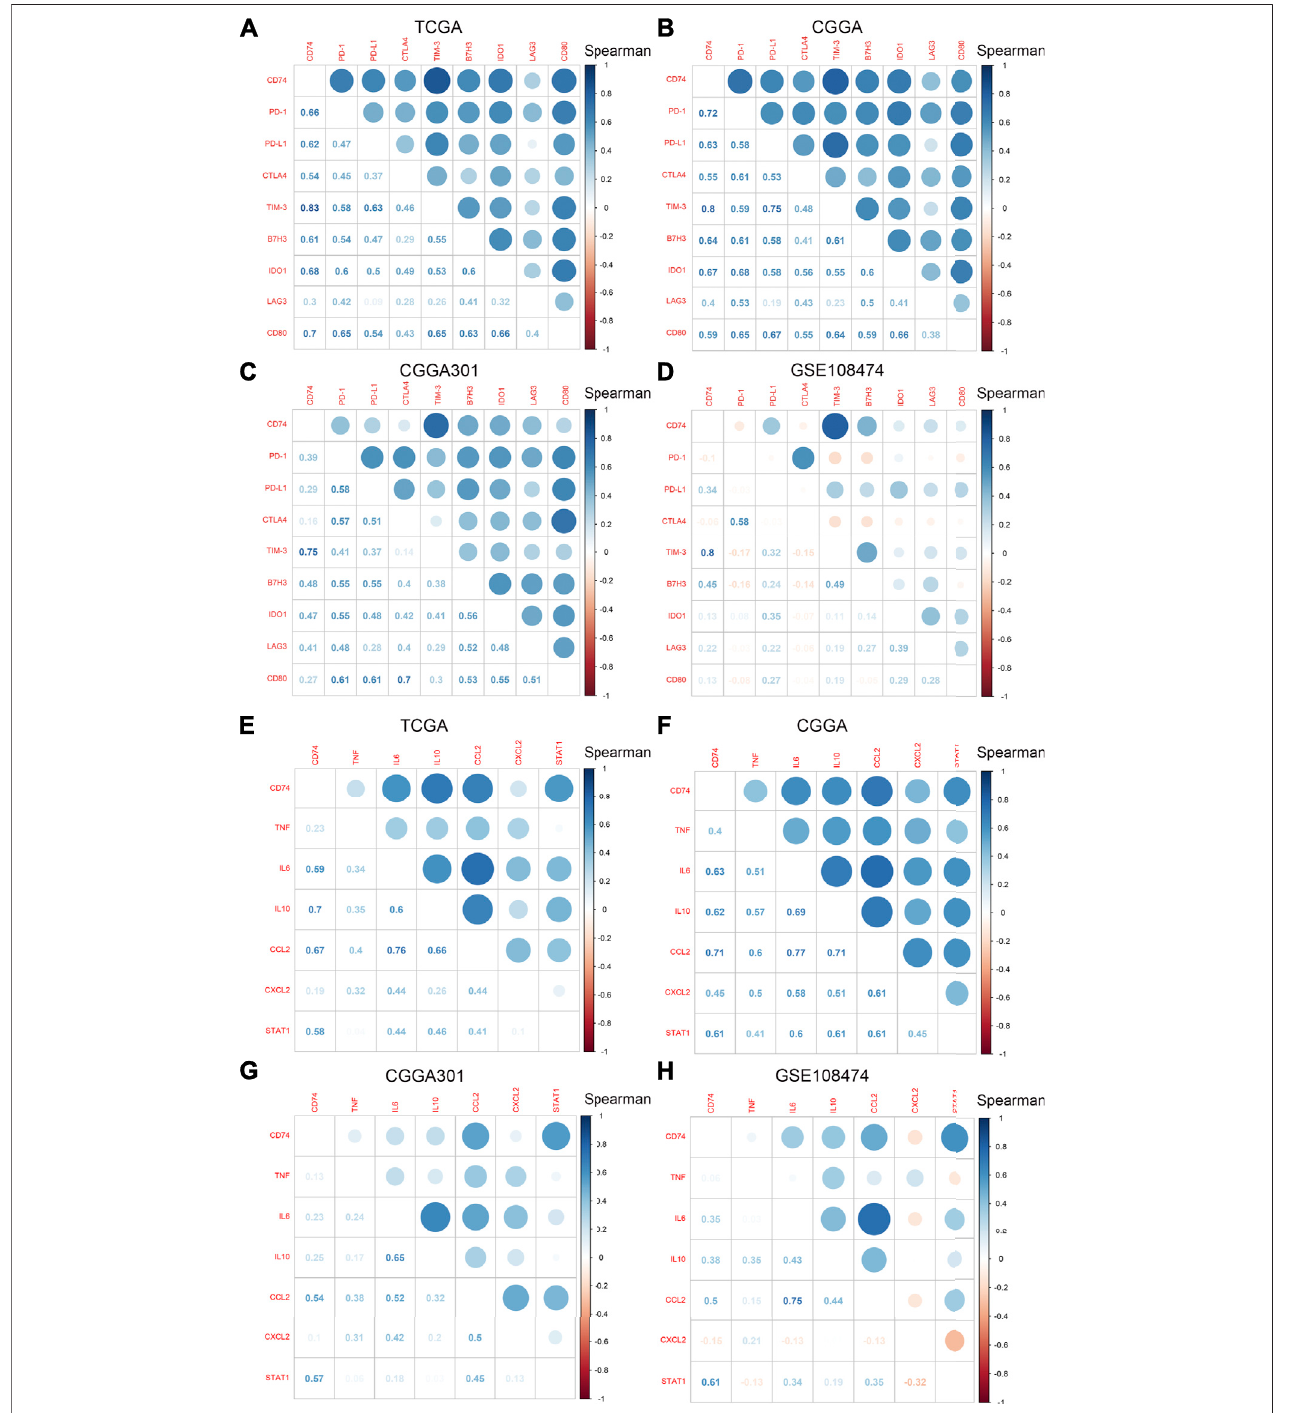
FIGURE 3 | Correlation between CD74 and immune checkpoints and in fl ammatory cytokines. A-D. Correlation between CD74 and immune checkpoints in TCGA (A) , CGGA (B) , CGGA301 (C) , and GSE108474 (D) datasets. E-H. Correlation between CD74 and in fl ammatory cytokines in TCGA (E) , CGGA (F) , CGGA301 (G) , and GSE108474 (H) datasets. Blue and red represented positive and negative correlation, respectively.